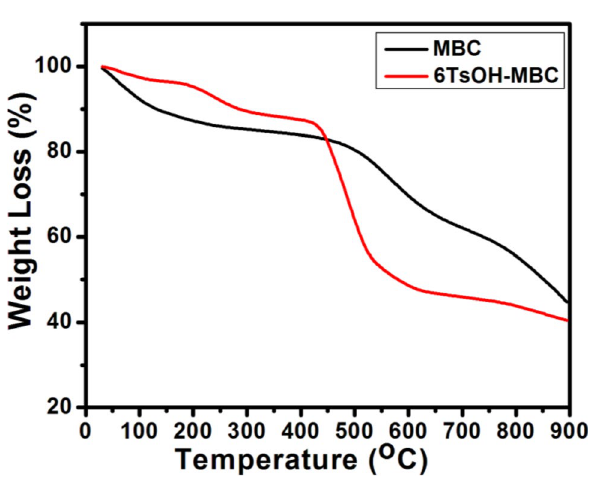
Figure 5. TGA of MBC and